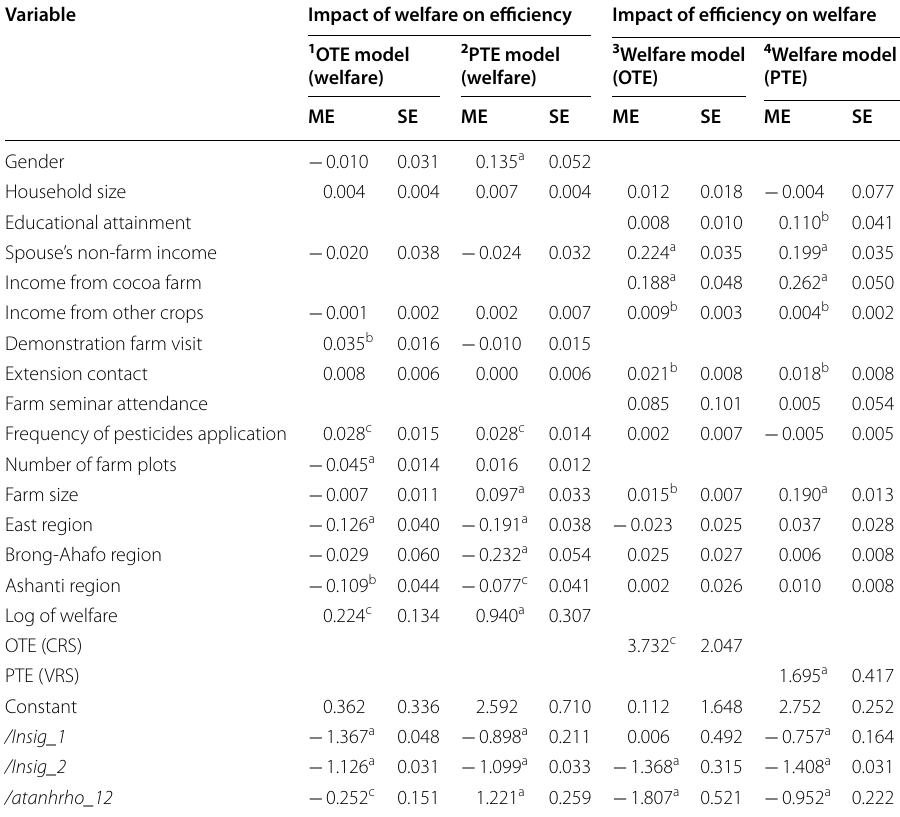
Table 3 Determinants of technical efficiency and the two-way impacts of efficiency and